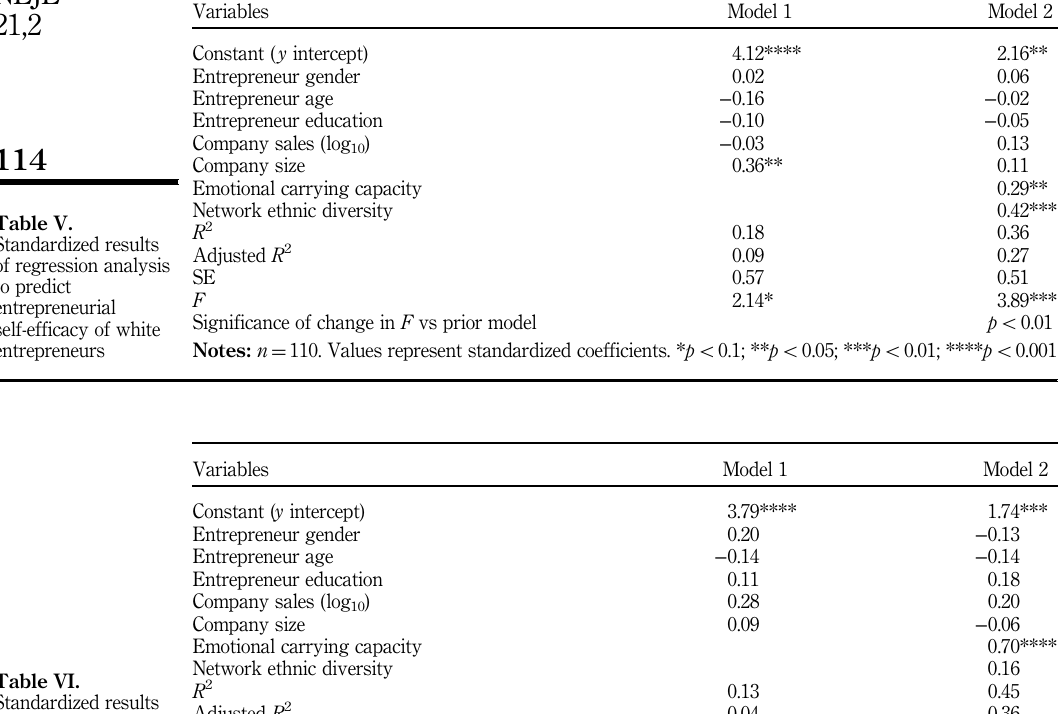
of regression analysis to predict entrepreneurial self-efficacy of Black